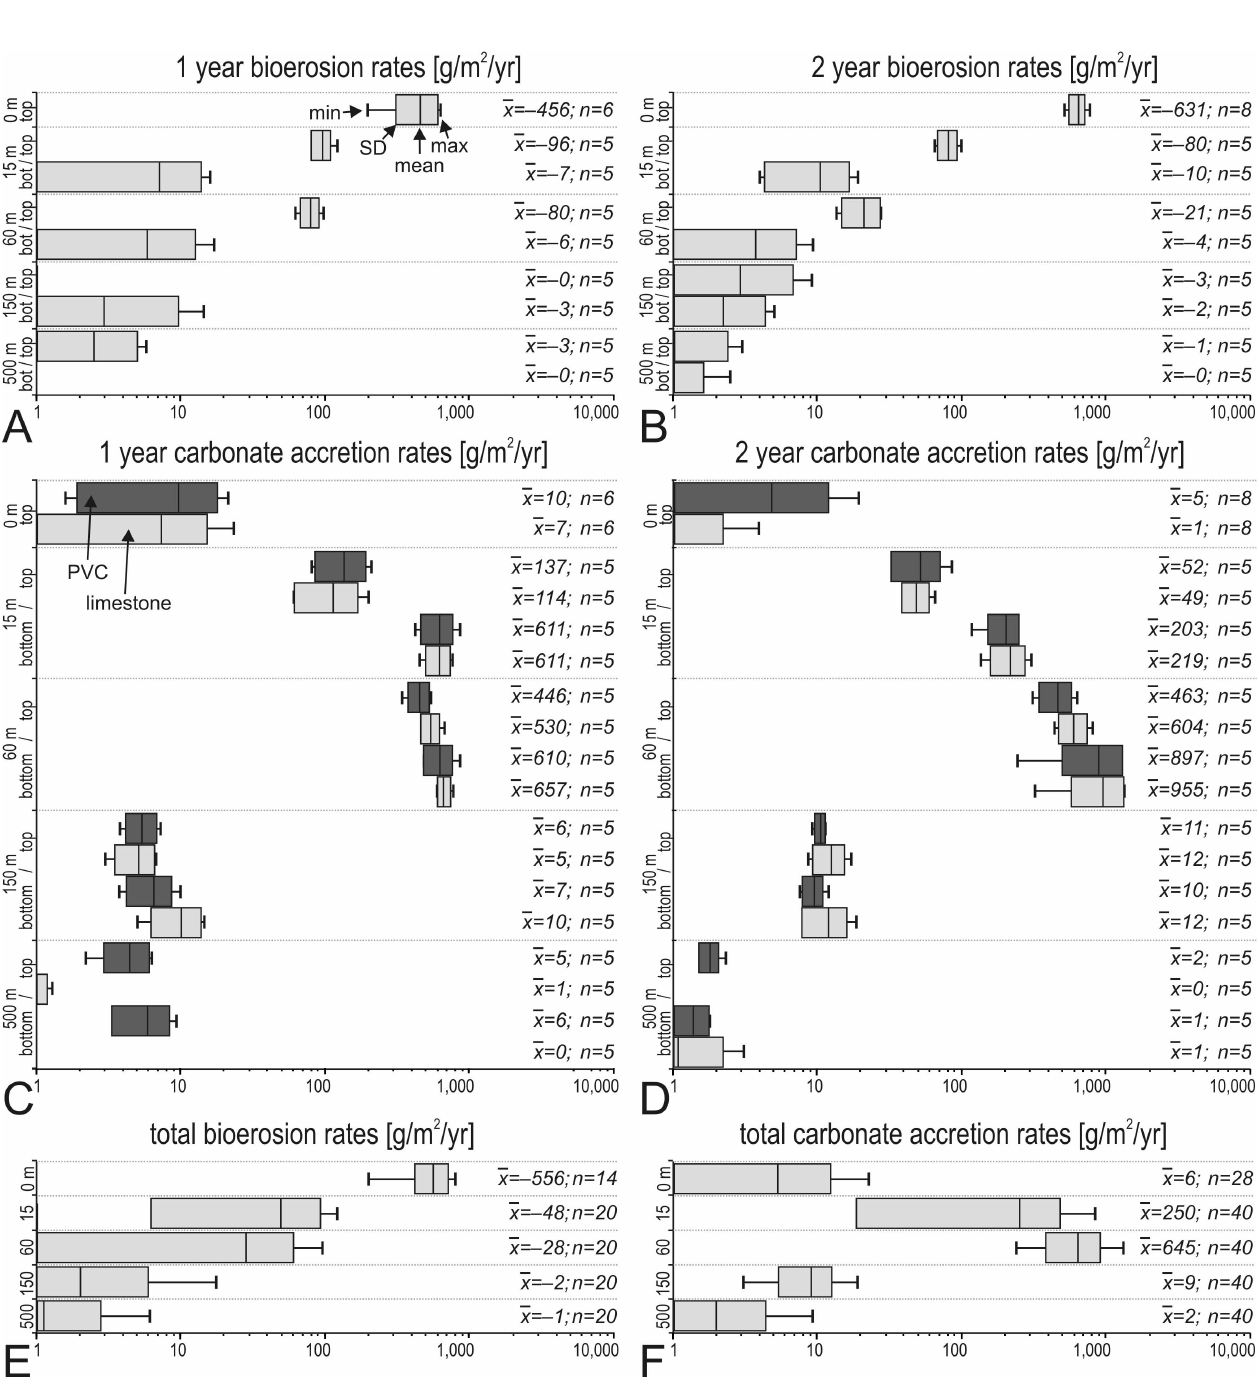
Fig. 6. Logarithmic plots showing mean values, SD, min/max and number of replicates of carbonate accretion and bioerosion rates in grams per square metre and year, gravimetrically determined via up- and down-facing limestone and PVC settlement plates on experimental frames in the southern Faial Channel in 0, 15, 60, 150, and 500m of water depth. (A–B) One and two year bioerosion rates. (C–D) One and two year carbonate accretion rates differentiated by substrate orientation and type. (E) Total carbonate bioerosion rates for combined orientations and exposure times. (F) Total carbonate accretion rates for combined substrate types, orientations, and exposure